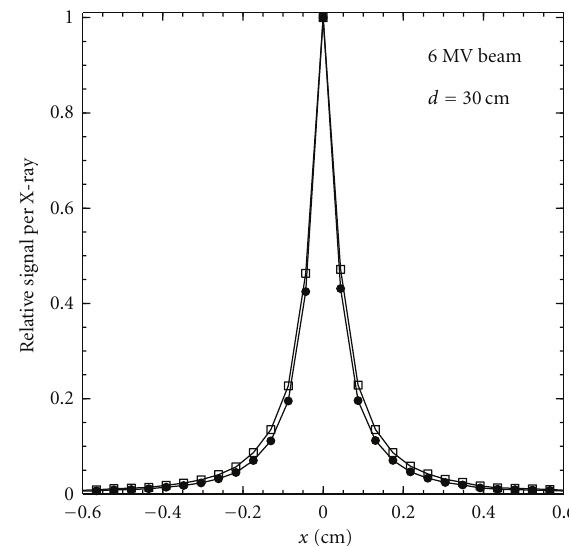
Figure 11: Renormalized spatial distributions of the detector signal for a 30cm thick CPID under irradiation of a 6MV pencil beam with (open squares) and without (solid circles) the presence of the water slab.